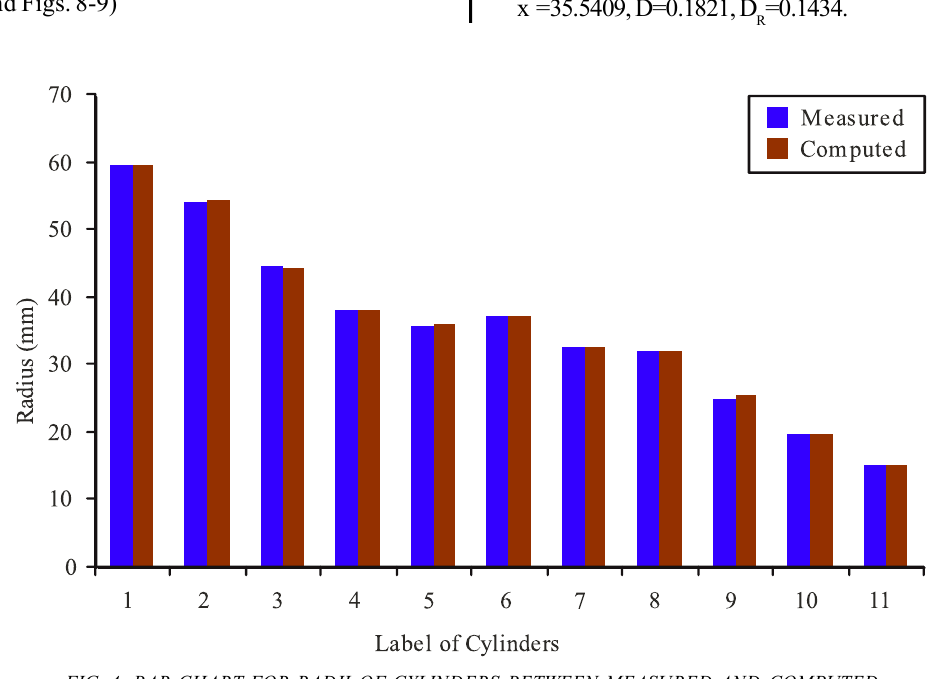
FIG. 4. BAR CHART FOR RADII OF CYLINDERS BETWEEN MEASURED AND COMPUTED